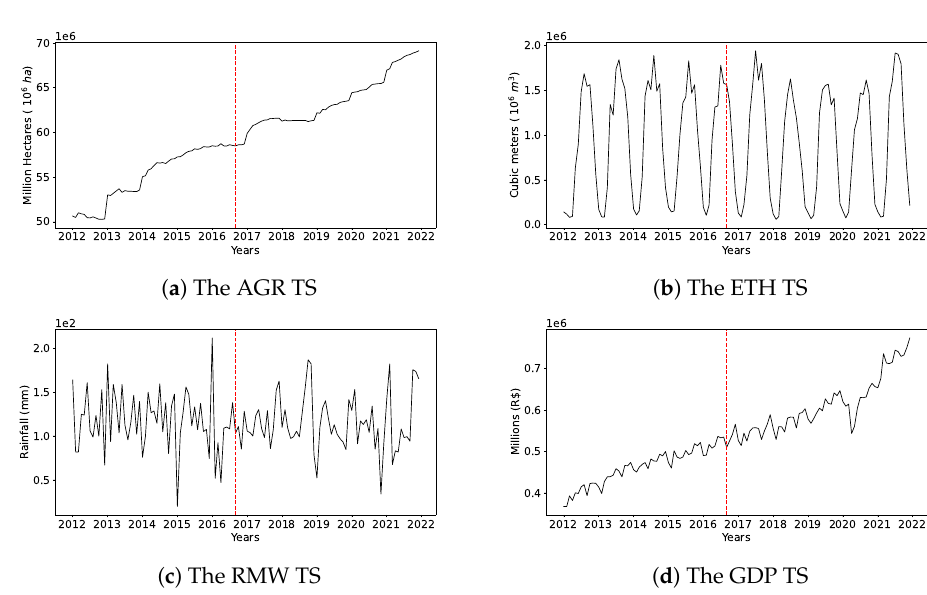
Figure 2. The key variables TS before seasonality